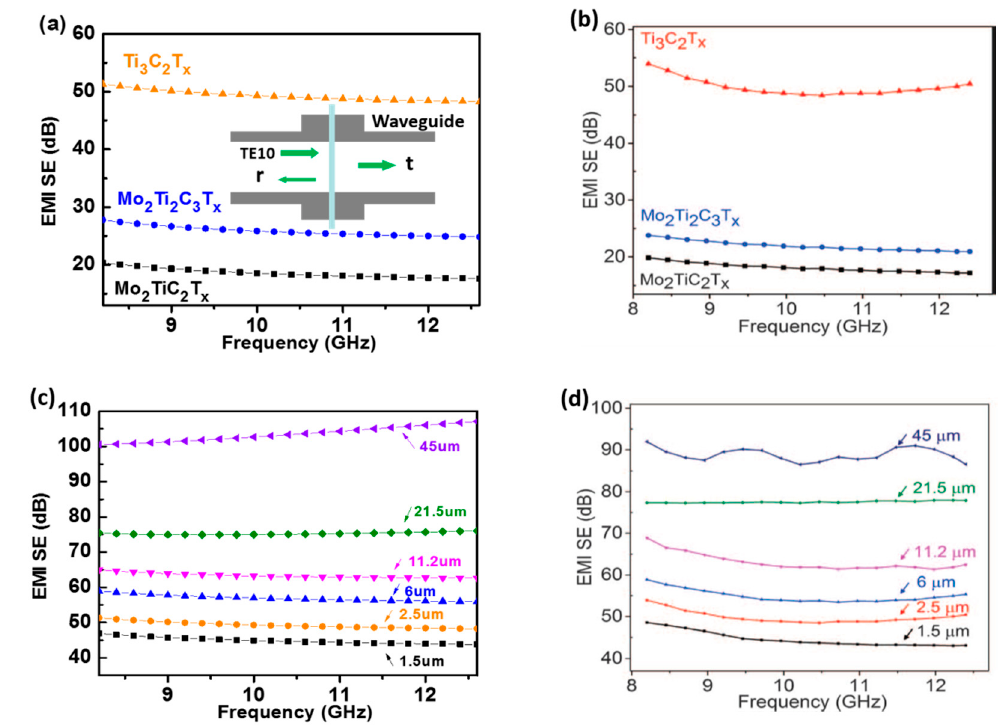
Figure 2. ( a ) Calculation of EMI shielding effectiveness of three MXene films with thickness and conductivity adapted from Ref. [8]. The inset of figure ( a ) is the schematic drawing of waveguide measurement. ( b ) Experimental results of EMI shielding effectiveness of three MXene films got from Ref. [8]. Reprinted with permission from AAAS. ( c ) Calculation of EMI shielding effectiveness of Ti 3 C 2 T x films with conductivity and different thickness adapted from Ref. [8]. ( d ) Measurement results of EMI shielding effectiveness of Ti 3 C 2 T x films with different thickness in Ref. [8]. Reprinted with permission from AAAS.